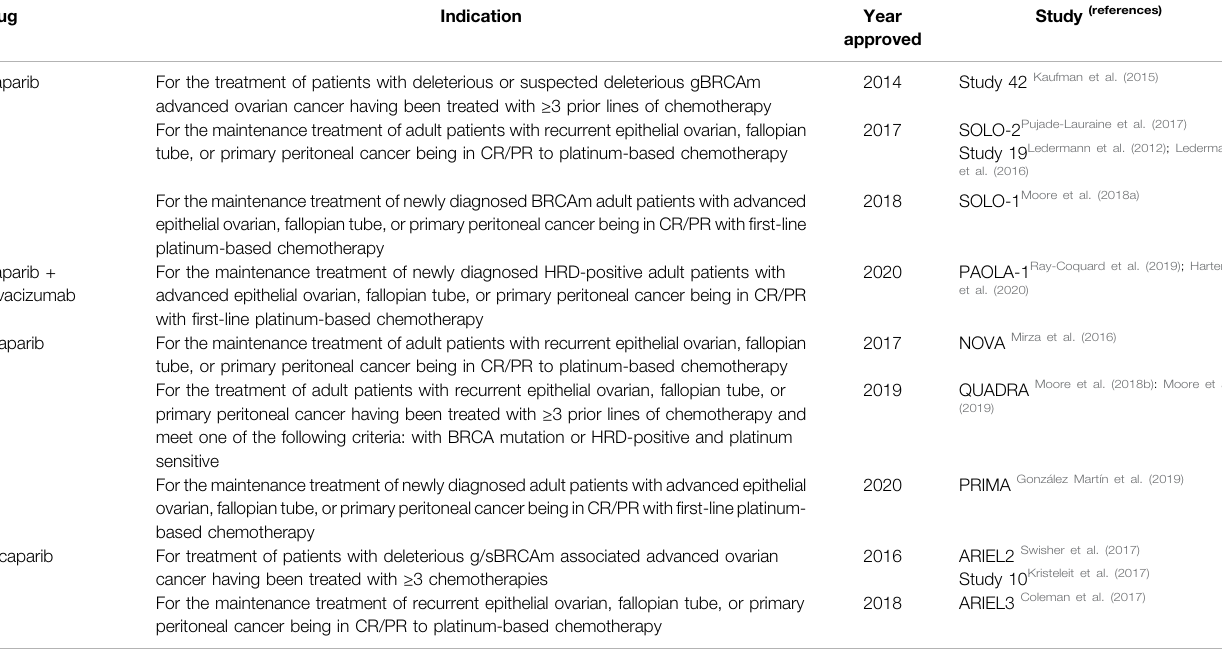
TABLE 1 | FDA approvals for PARP inhibitors in patients with ovarian, fallopian tube, and primary peritoneal cancers. Drug